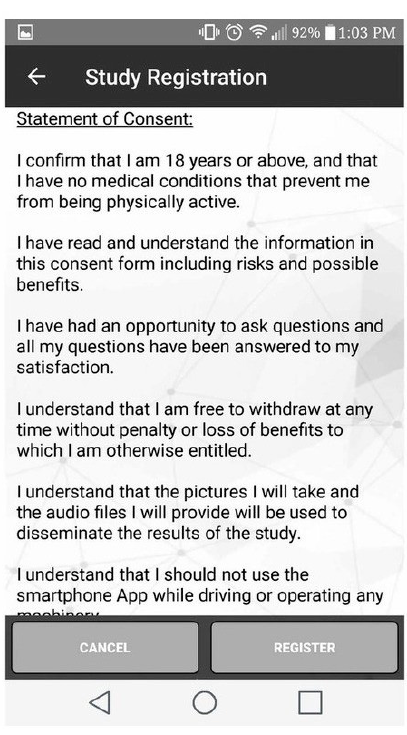
Figure 3. Informed consent provided via smartphone app.